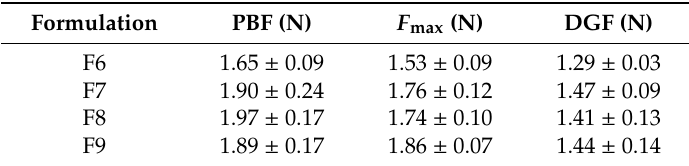
Table 4. Injectability parameters of the formulations suspended in distilled water with 22-guage needles (mean ± SD, n = 3).